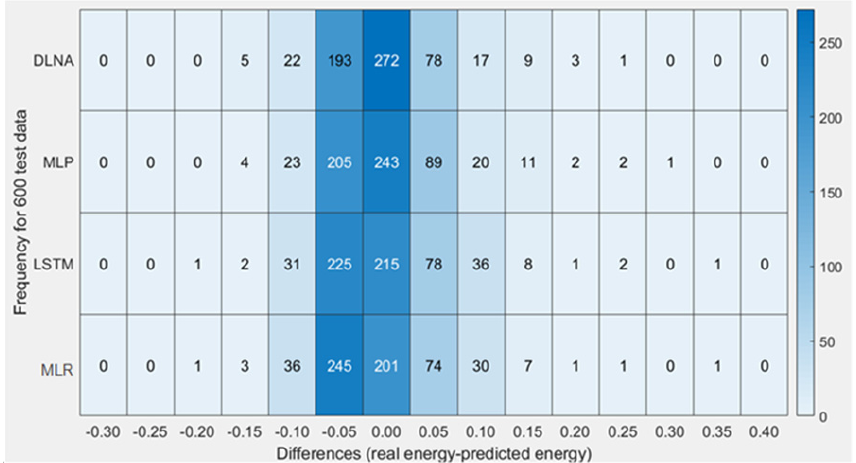
Figure 14. Heatmap for frequency of differences between the actual and predicted values for 600 test data.